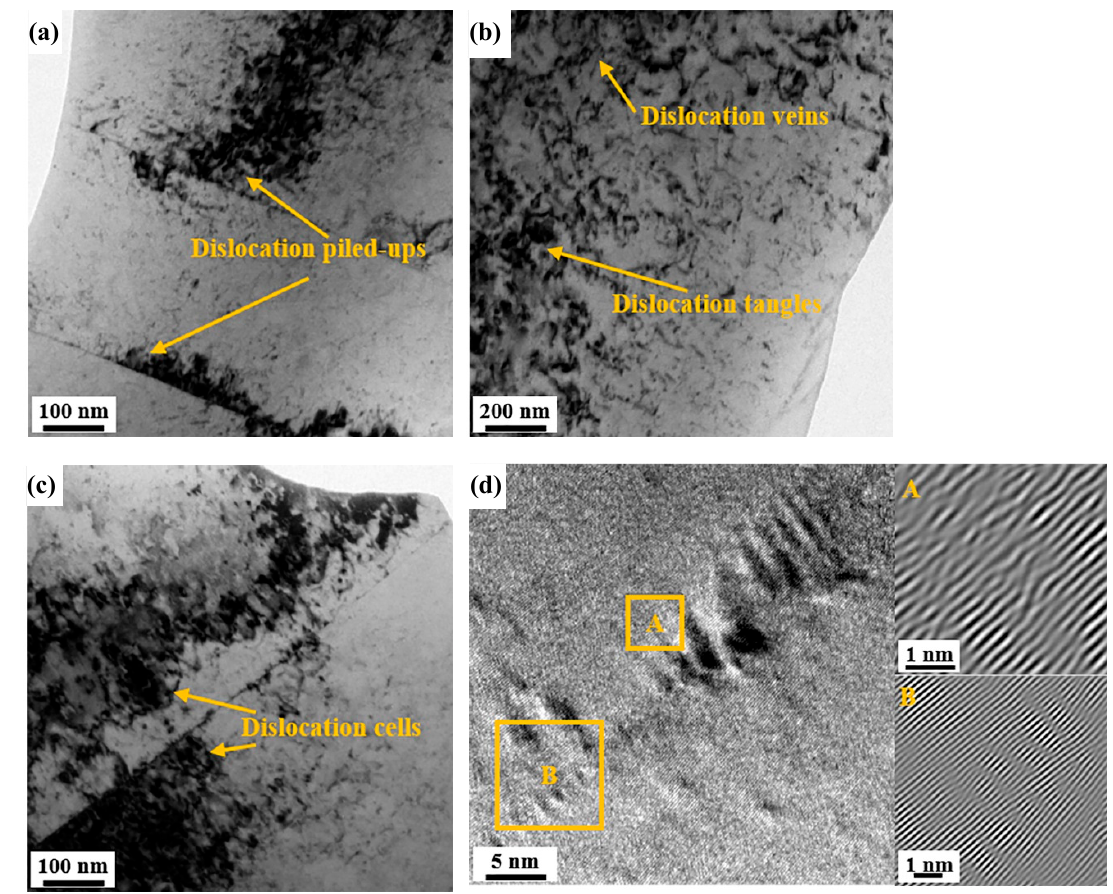
Figure 7. Transmission electron microscope (TEM) images of the AFA steel with 30% cold rolling reduction. ( a ) Dislocation piled-ups, ( b ) dislocation veins and tangles, ( c ) dislocation cells and ( d ) high-resolution TEM (HRTEM) of ( c ) revealing the dislocation characters nearby the grain boundary by inverse fast Fourier transform (IFFT) of Areas A and B.